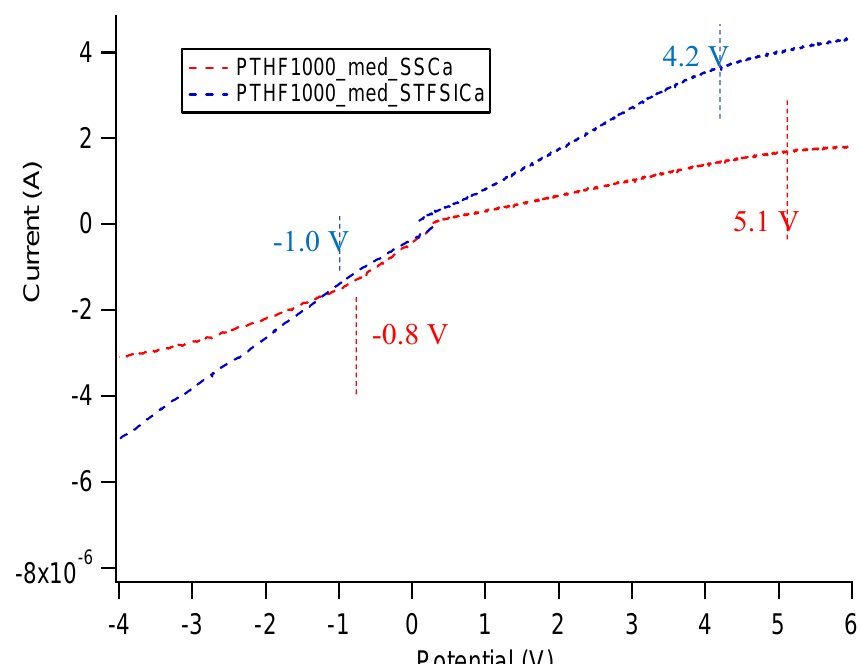
Figure A34. Oxidative and reductive stability of diglyme and diglyme gelled Ca exchanged SIPEs. Configuration is stainless steel/Pt.